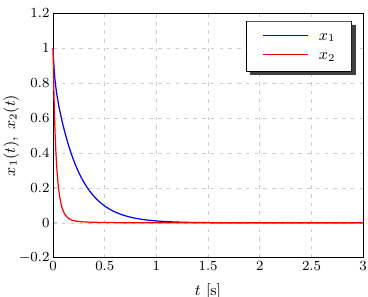
Figure 4. Time dependence of the state variables (Example 4.2).